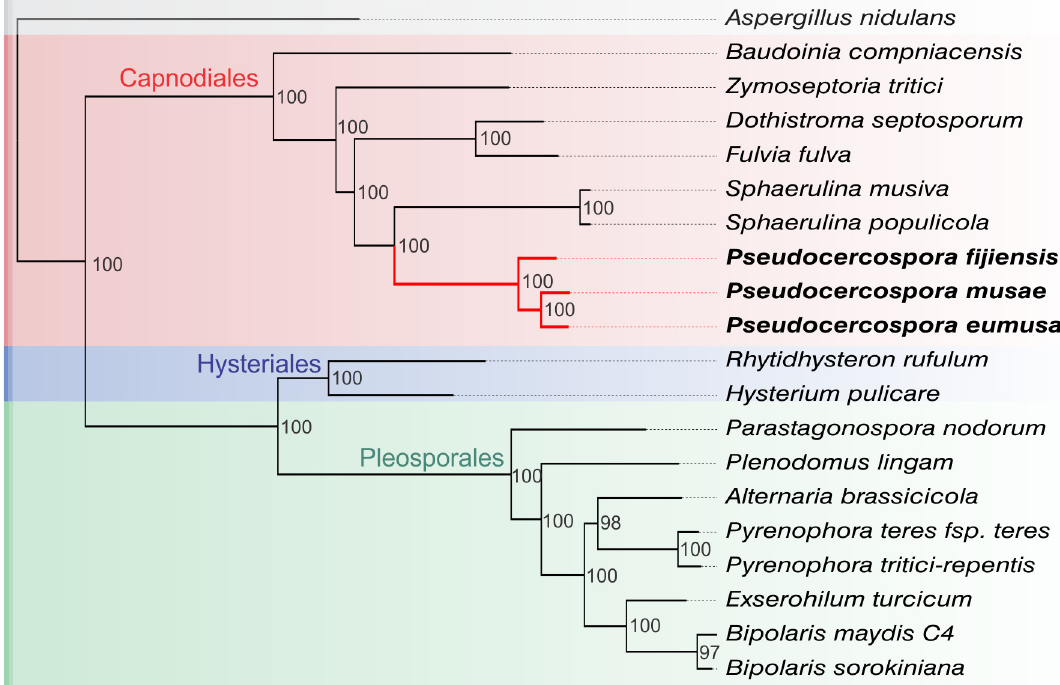
Fig 3. Molecular phylogeny of the three species that constitute the Sigatoka disease complex and 16 other representative Dothideomycetous fungi. The maximum likelihood (ML) tree was constructed based on a concatenated sequence alignment of 46 orthologous single-copy genes. Bootstrap values (%) are indicated next to corresponding branching nodes. Aspergillus nidulans (class of Eurotiomycetes) was used as an outgroup species for rooting the tree. The selected 16 representative Dothideomycete species that are included in the phylogeny fall into three major orders, i.e. Capnodiales (red), Hysteriales (blue), and Pleosporales (green). In the inferred topology P . musae , P . eumusae , and P . fijiensis are strongly clustered (bootstrap value of 100%) as a monophyletic clade within the Capnodiales, whereas P . eumusae is sister to P . musae (bootstrap value of 100%), suggesting an earlier split of P . fijiensis from the common ancestor of these two